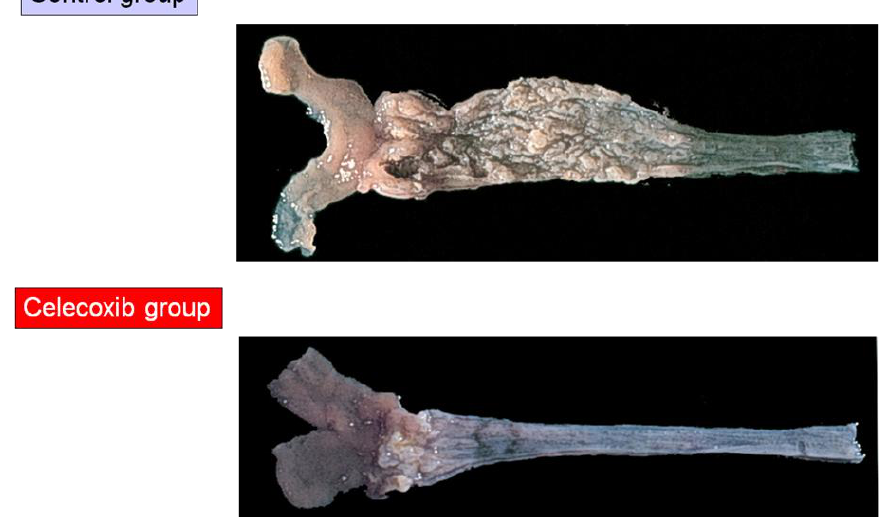
Table 2. Incidence of regenerative changes, Barrett’s esophagus and adenocarcinoma. Incidence (%) of No. of Weeks Group animals BCH